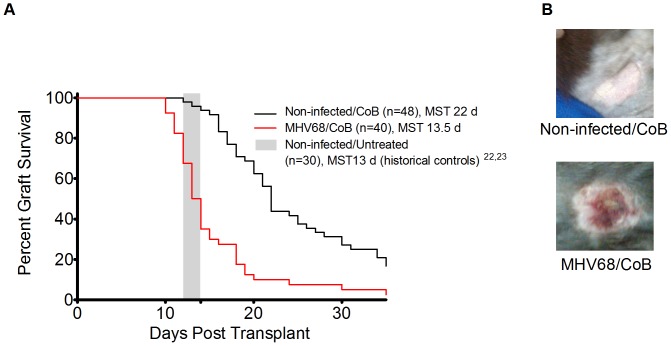
Latent infection with MHV68 results in abbreviated skin allograft survival.A) Kaplan-Meier survival curves showing skin graft survival for the following cohorts: Black solid line - Non-infected B6 recipients of BALB/C skin allografts, receiving CTLA-4-Ig+anti-CD154 CoB. N = 48, 8 independent experiments, MST 22 d. Red solid line - MHV68-infected B6 recipients of BALB/c skin allografts receiving CTLA-4-Ig+anti-CD154 CoB. N = 40, 7 independent experiments, MST 13.5 d. Grey box - indicates MST from two historical control cohorts [22], [23] of non-infected B6 recipients receiving BALB/c skin grafts without any immunosuppression (MST 13 d). Statistical Analysis: Log-rank comparison of MHV68-infected/CoB treated versus non-infected/CoB treated yielded p<.0001. Log-rank comparison of MHV68-infected/CoB treated to non-infected/no immunosuppression yielded a non-significant p-value. B) Representative skin allografts from mice 12 days after graft placement. The graft on the non-infected animal remains healthy and pristine while the graft on the animal infected with latent MHV68 demonstrates necrosis, scarring, and erythema.